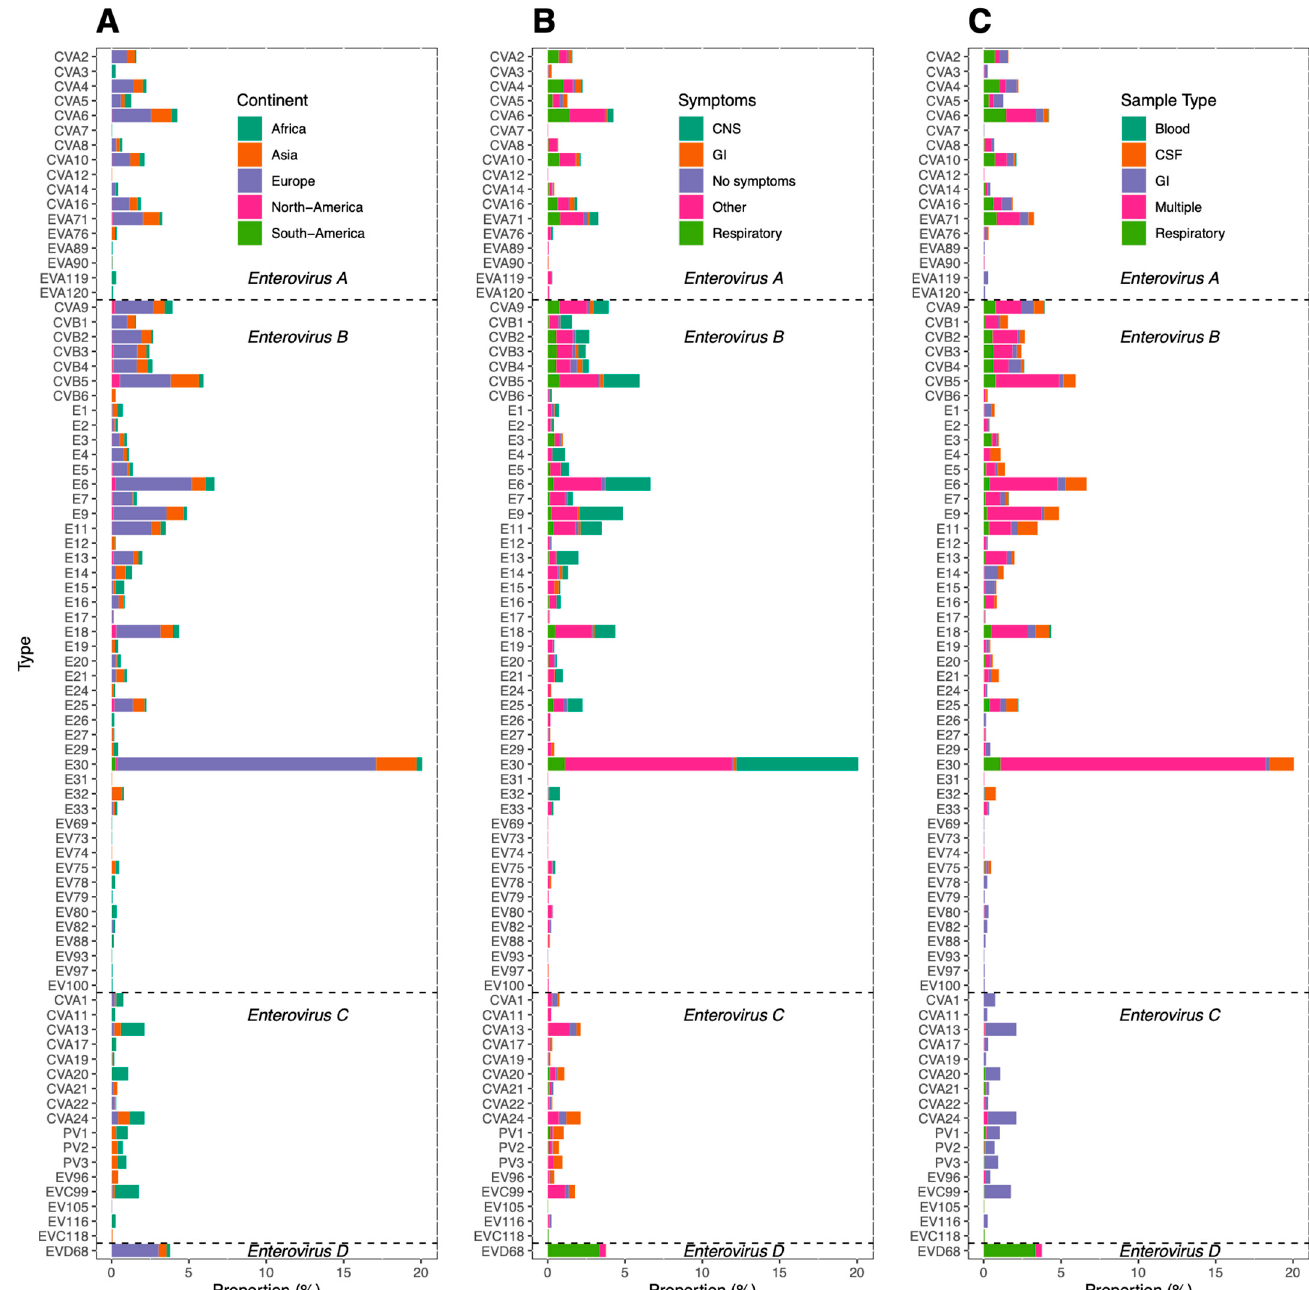
Figure 5. EV type distribution reported by all studies describing EV type distribution. The proportion of each reported type among the total number of reported typed strains is shown, colored by ( A ) continent, ( B ) symptoms and ( C ) sample types. GI; gastrointestinal, CNS; central nervous system, CSF; cerebrospinal fluid.